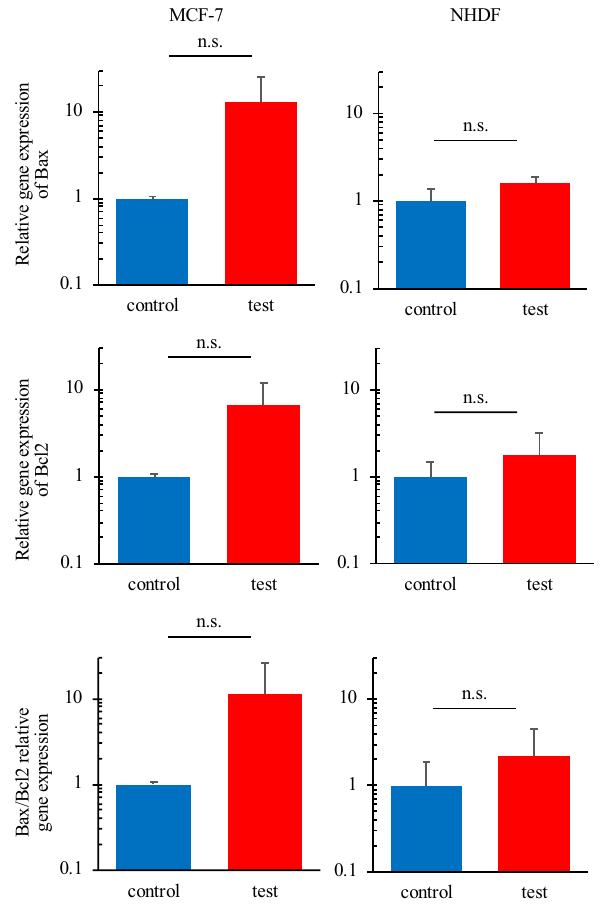
Figure 6. Relative mRNA expression levels of apoptosis-related genes. Cancer cells showed more prominent apoptosis than normal cells ( n = 3, mean ±